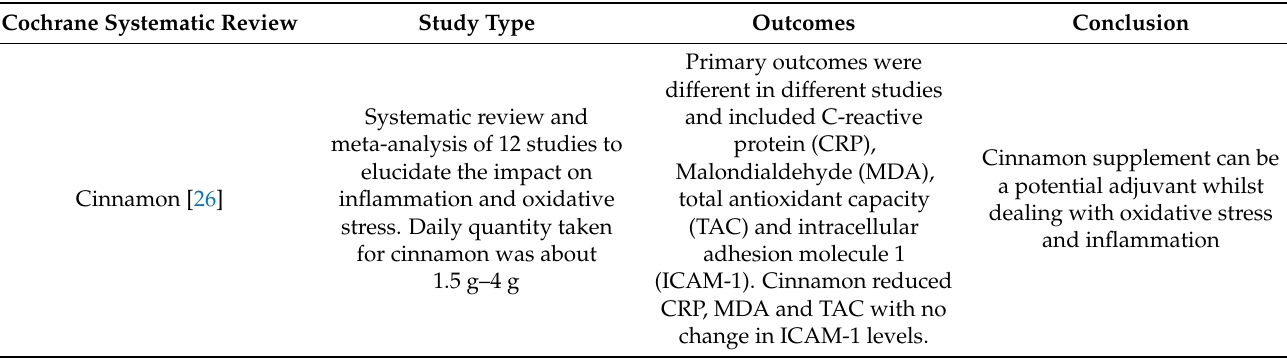
Table 2. Examples of nutraceuticals with therapeutic effects reviewed by Cochrane Systematic Reviews between the years 2004 and